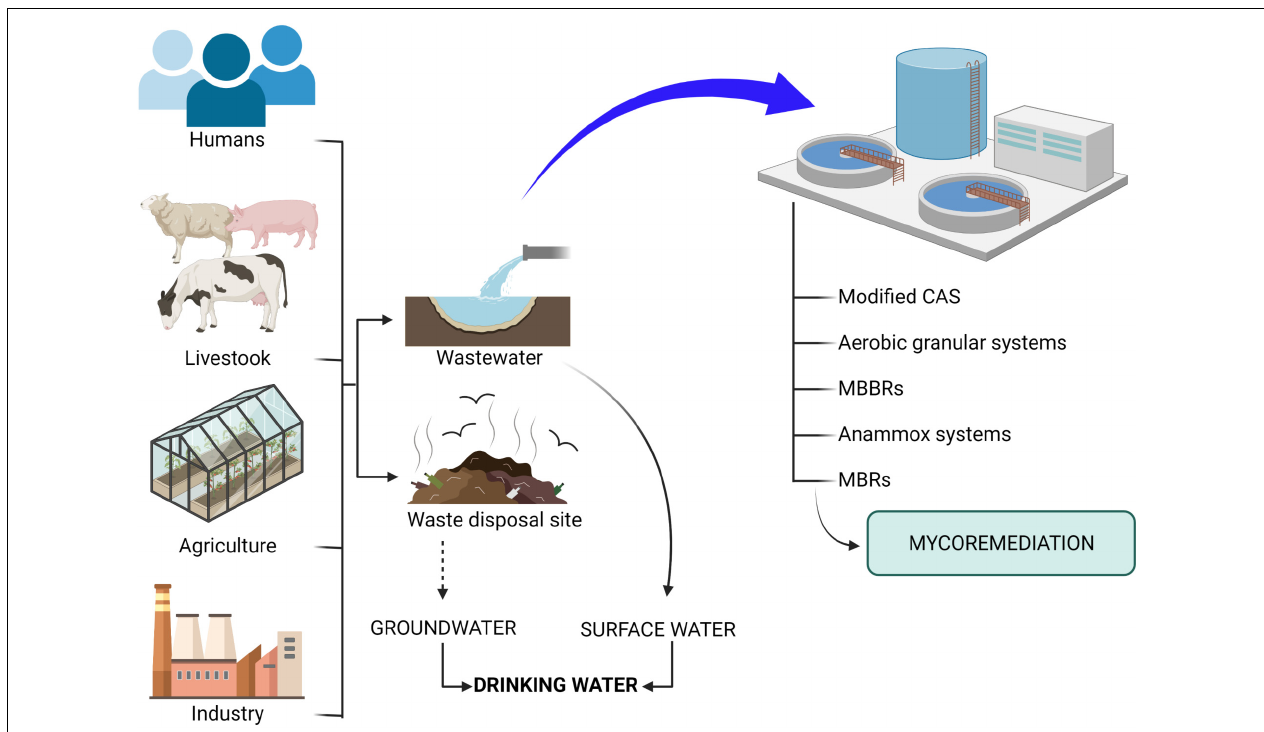
FIGURE 1 | Pharmaceuticals route to a body of water and bioremediation technologies. ( → ): Direct contamination. ( (cid:57)(cid:57)(cid:75) ): Contamination through different steps. The monitoring suggests that contamination accumulates in surface water and